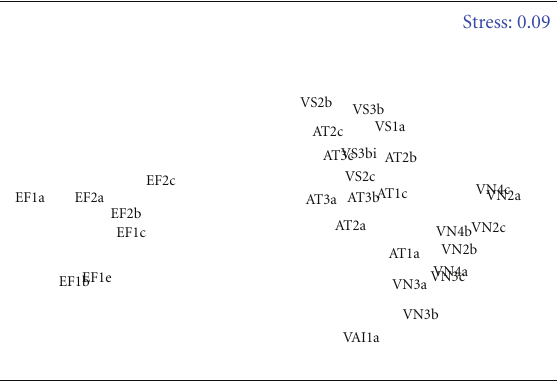
Figure 3: Plot of Multidimensional Scaling (MDS) using Bray- Curtis similarity matrix of macroinvertebrate biomasses (dry weight) in 2000. 1,2,3: pond replicates; a, b, c: spatial replicates within pond; VN: Vau; VAI: Vaia; AT: Atalaia; EF: Esteiro-Furado; VS: